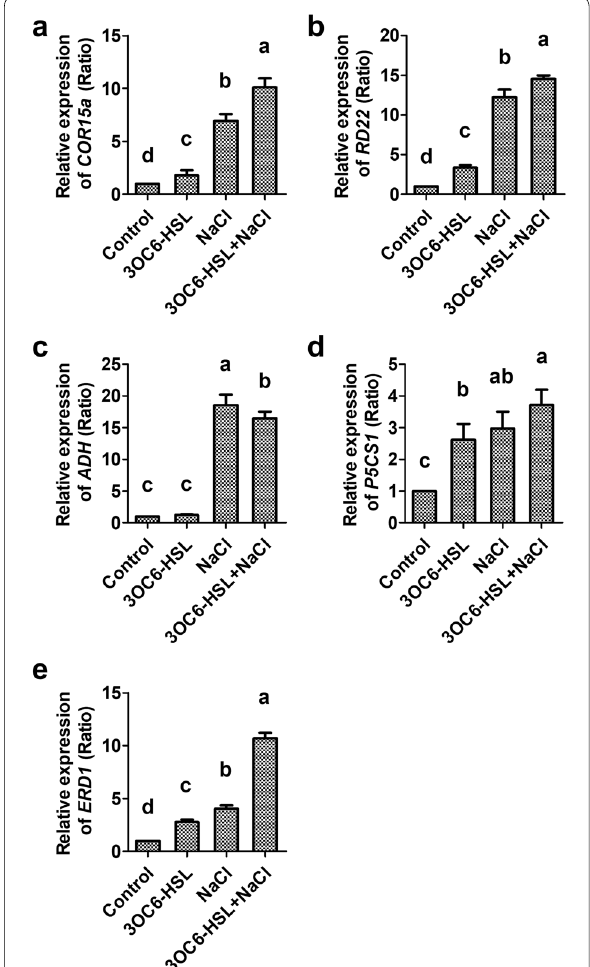
Fig. 5 Effect of 3OC6‑HSL on the expression of ABA‑dependent and ABA‑independent genes in Arabidopsis. 20‑day‑old seedlings were treated with 1 μM 3OC6‑HSL or/and 150 mM NaCl as indications. The relative gene expression of COR15a ( a ), RD22 ( b ), ADH ( c ), P5CS1 ( d ) and ERD1 ( e ) were measured by qRT‑PCR after treatment for 6 h in Arabidopsis. Values are mean SD of three independent ± experiments. Different letters indicate statistically significant differences ( P < 0.05, Duncan’s